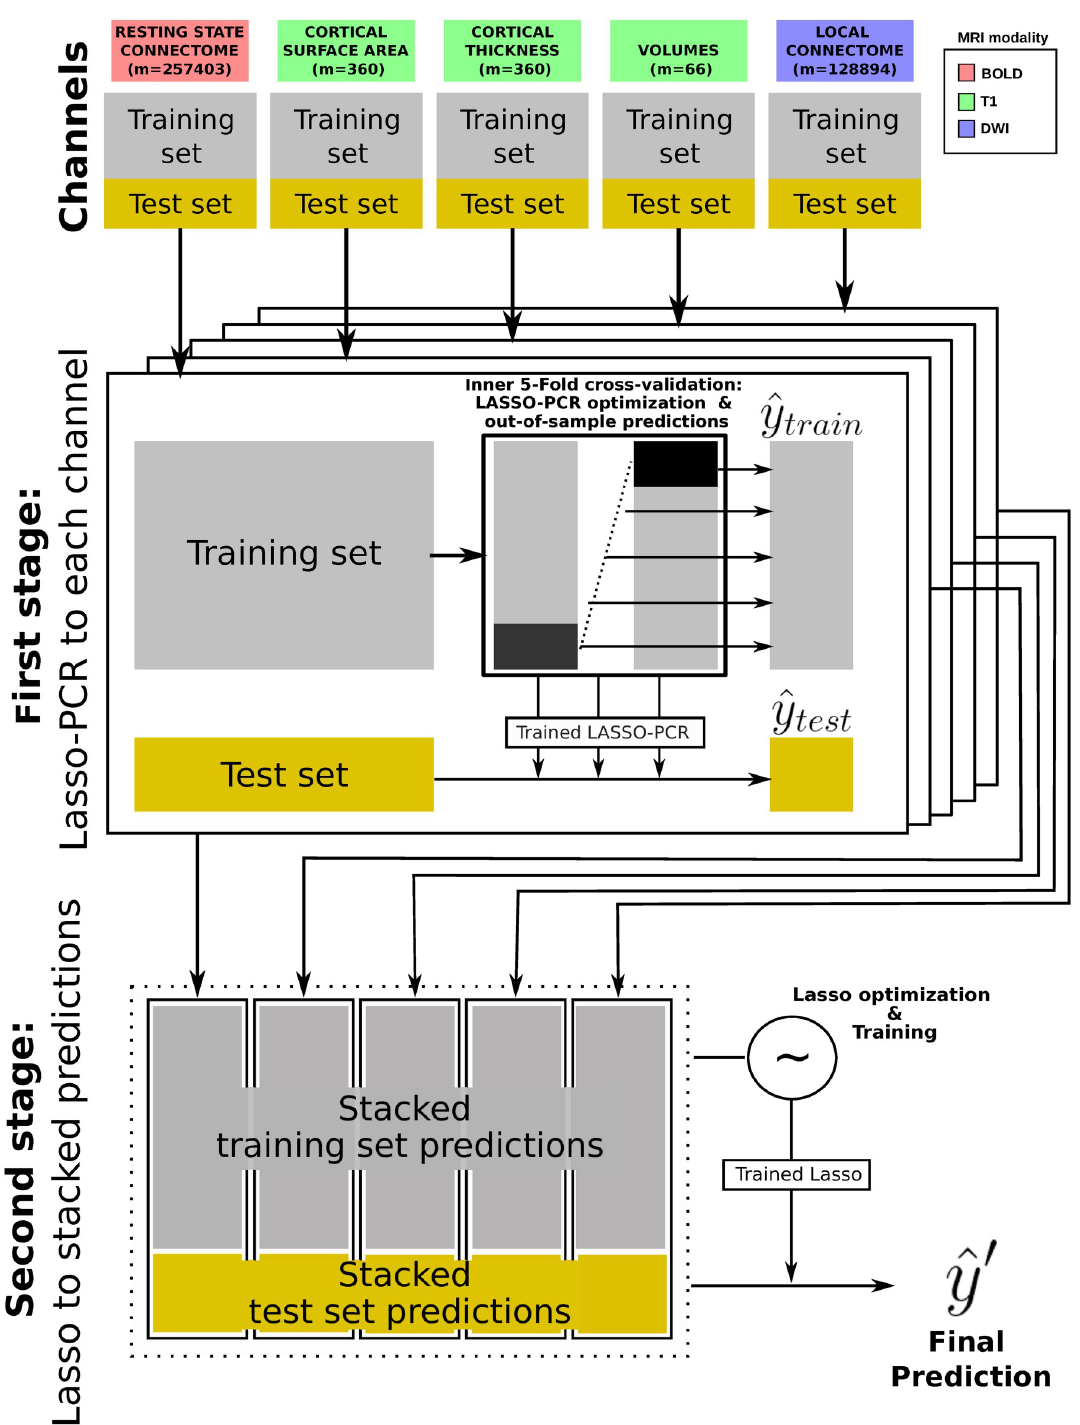
Fig 1. Stacking methodology for multi-modal data prediction. In the first step and for each brain measurement, a 5-fold cross- validation is applied to the training set to simultaneously optimize a LASSO-PCR model and produce out-of-sample training set predictions. The optimized trained LASSO-PCR model is then used to generate predictions from the test set. In the second learning step, training and test set predictions are stacked across channels. A new LASSO model acting on the new training set matrix is then optimized with an inner 5-fold cross-validation and fitted to generate the final predictions on the new test set.